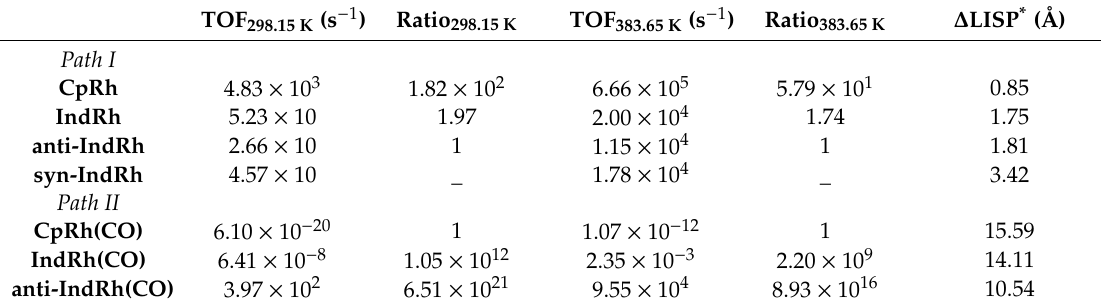
Table 7. Calculated TOF (s − 1 ) and slippage span ∆ LISP cycloaddition of acetylene to